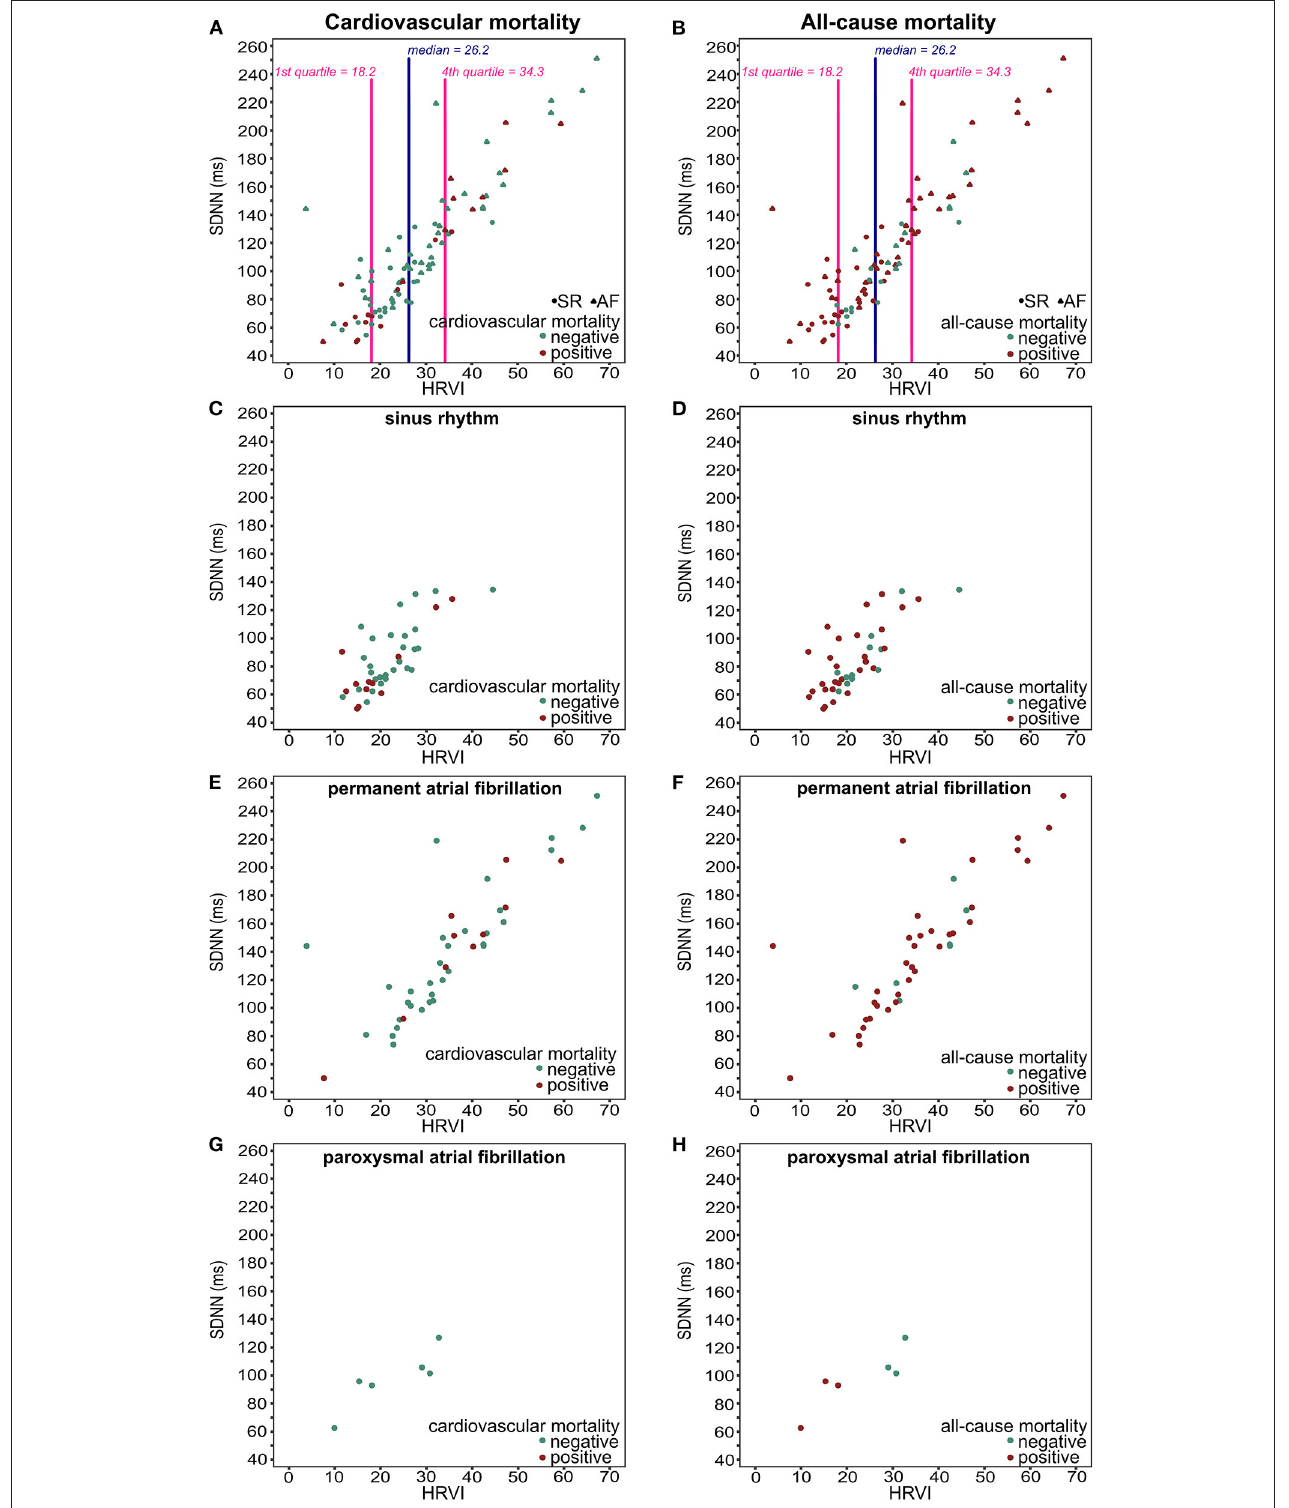
FIGURE 5 | Scatter plots of HRVI and SDNN for all patients (A,B) , patients in sinus rhythm (C,D) , patients in permanent atrial fibrillation (E,F) , and patients in paroxysmal atrial fibrillation (G,H) displayed for cardiovascular mortality (left column), and for all-cause mortality (right column). HRVI, heart rate variability triangular index; SDNN, standard deviation of all NN